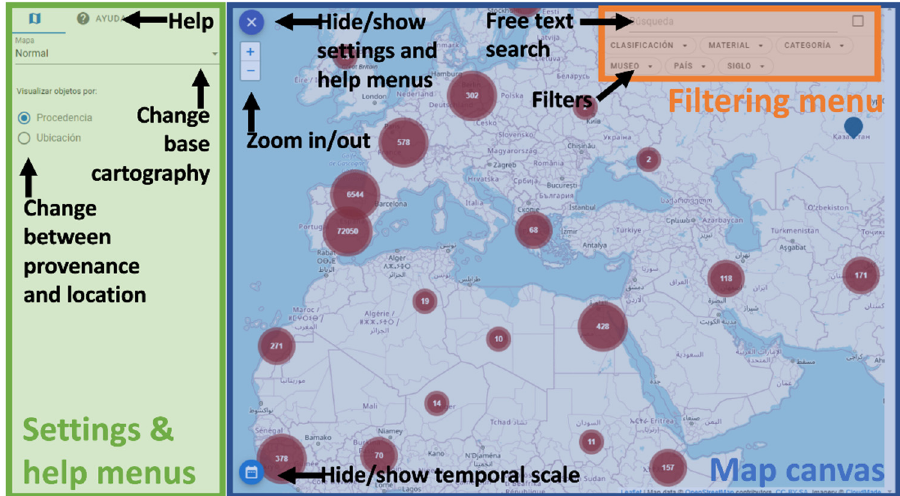
Figure 2. Overview of the elements integrated into the SeMap tool